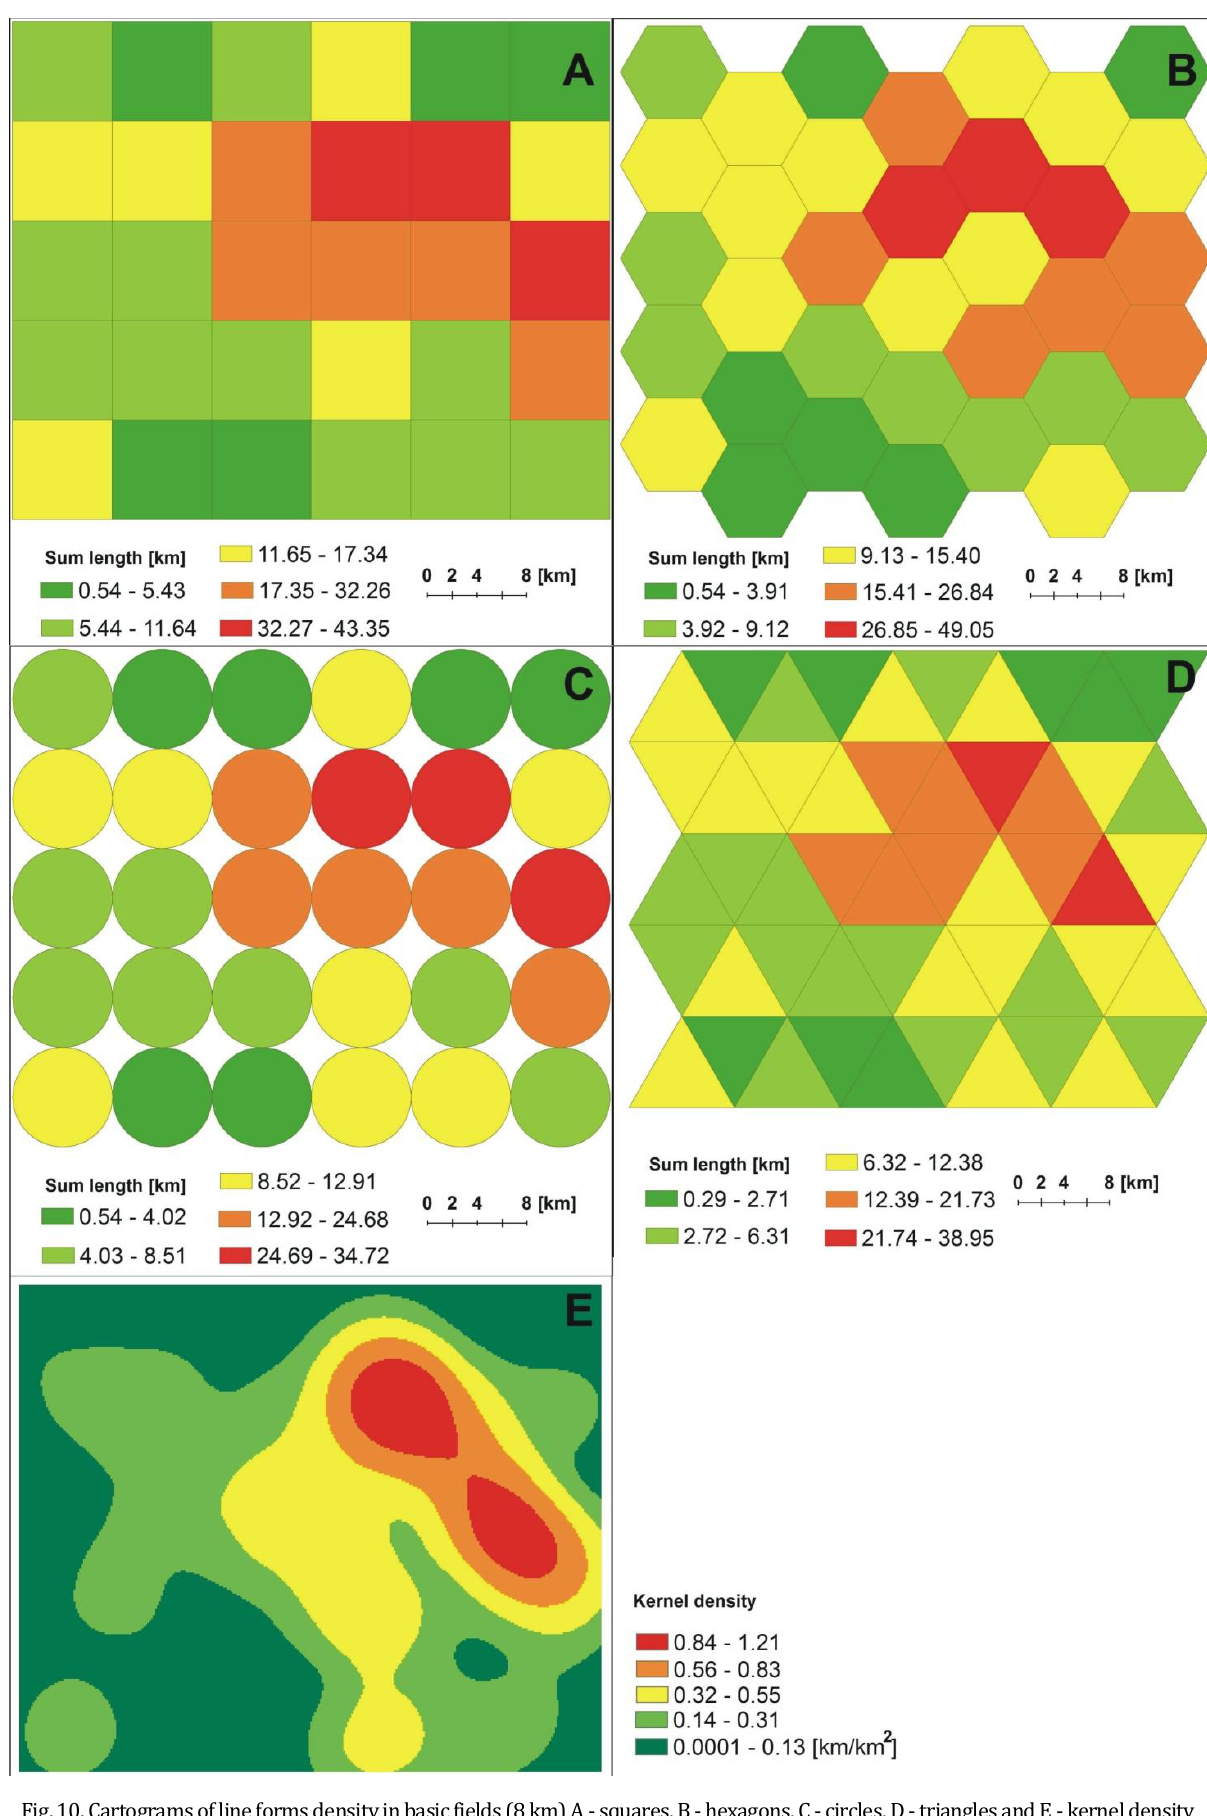
Fig. 10. Cartograms of line forms density in basic fields (8 km) A - squares, B - hexagons, C - circles, D - triangles and E - kernel